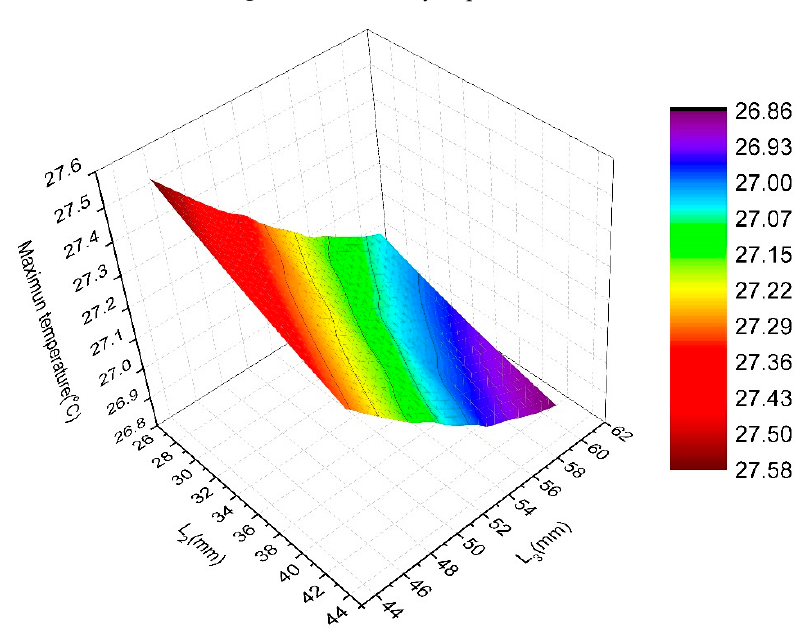
Figure 22. L 2 , L 3 and temperature surrogate model.